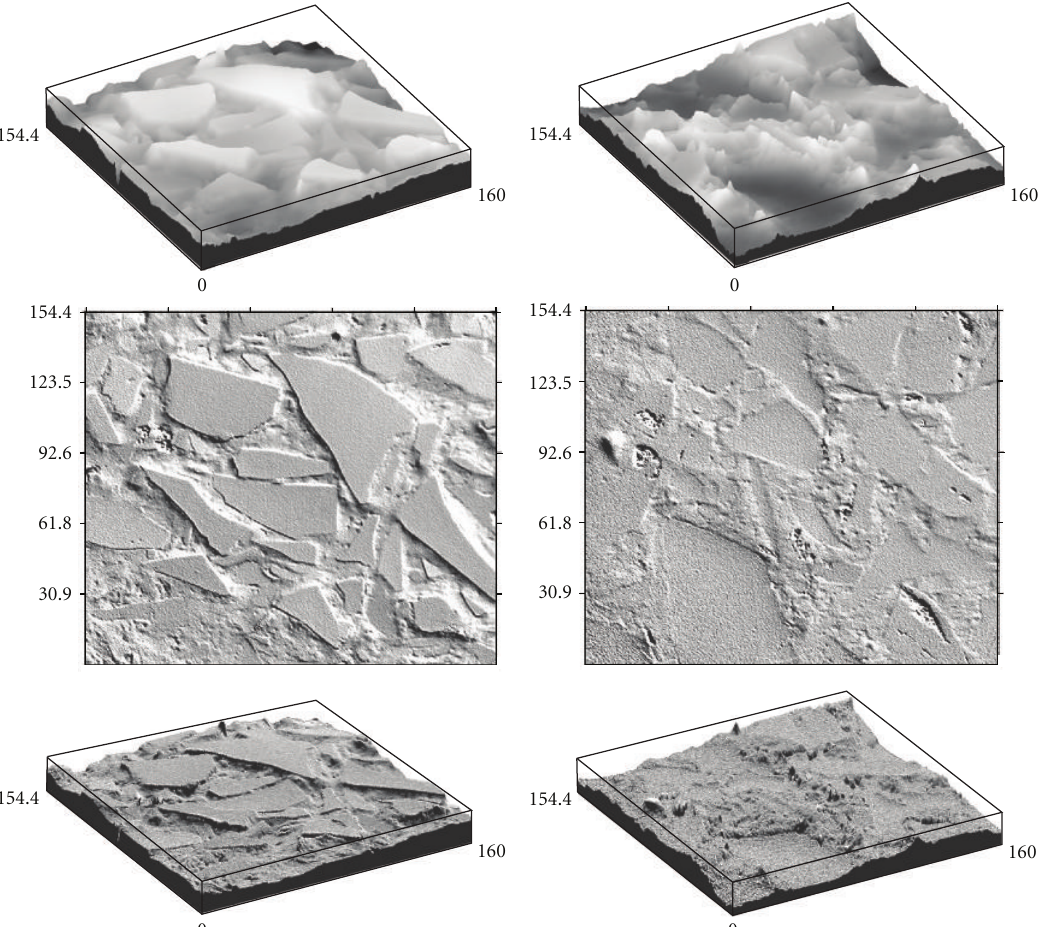
Figure 10: Confocal profiler 3D images of polymer with BAG particles showing the topographical di ff erences between light-cured and oven-cured